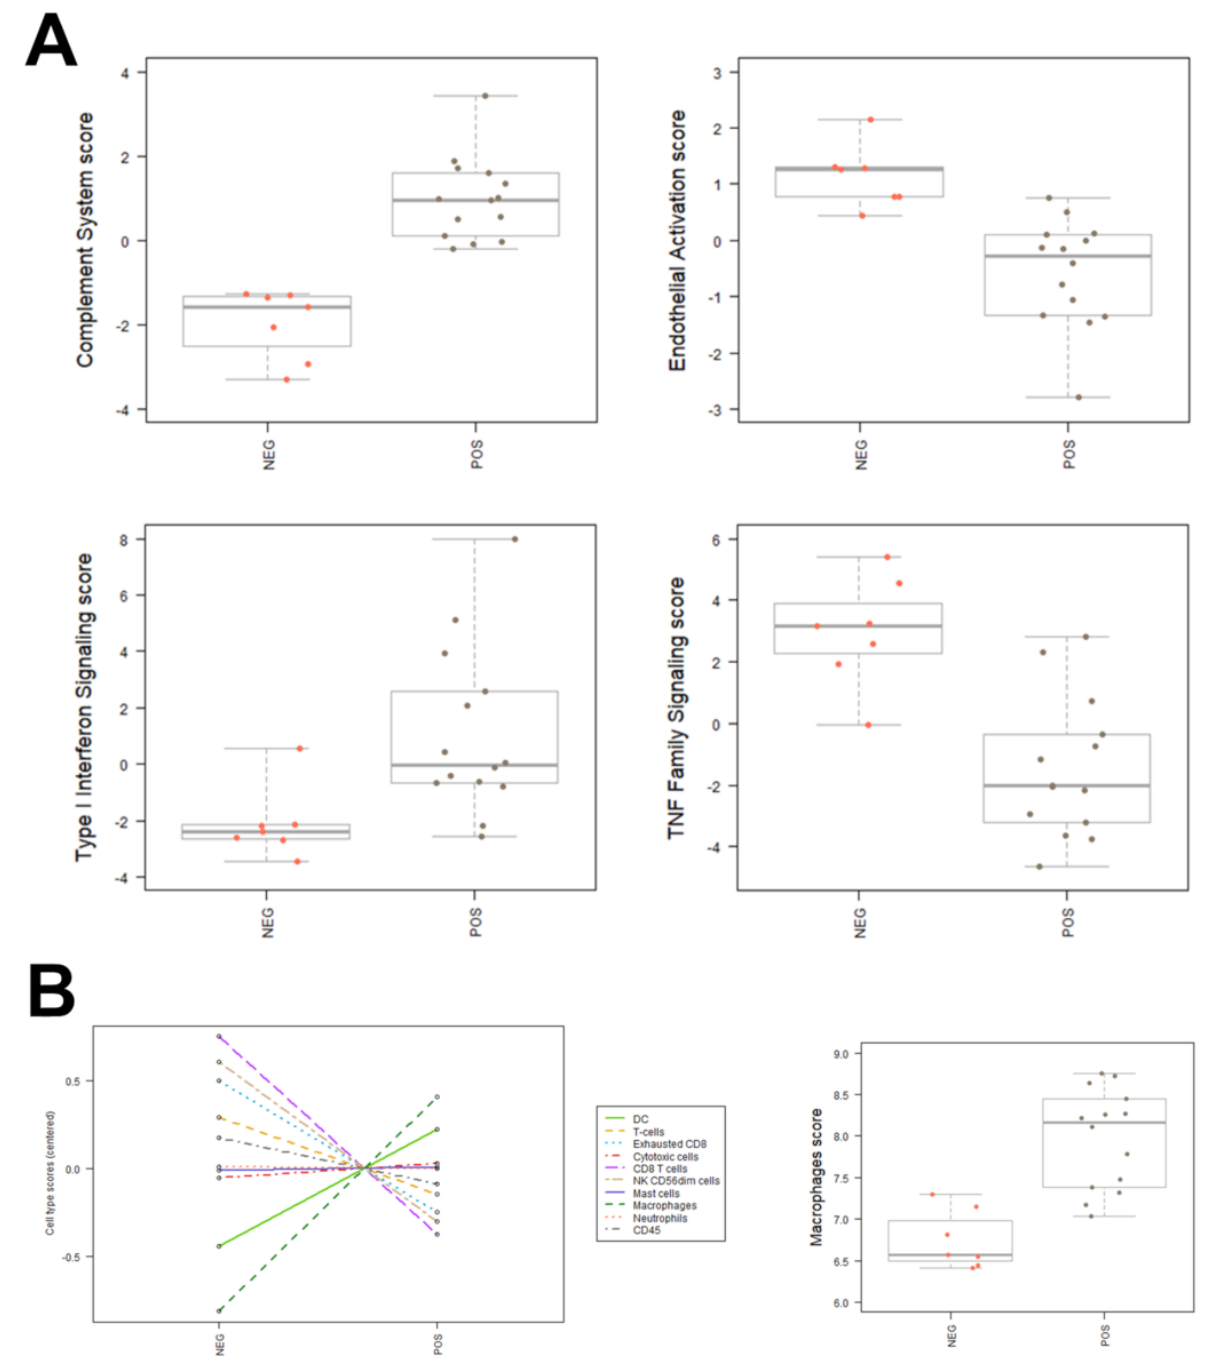
Figure 3. Main inflammatory pathways and cell types involved in SARS-CoV-2 infection. ( A ) Boxplots of effectors of complement system, endothelial activation, type I interferon signaling, TNF family signaling and macrophages in samples and controls. ( B ) Distribution of cell types between samples (pos) and controls (neg).